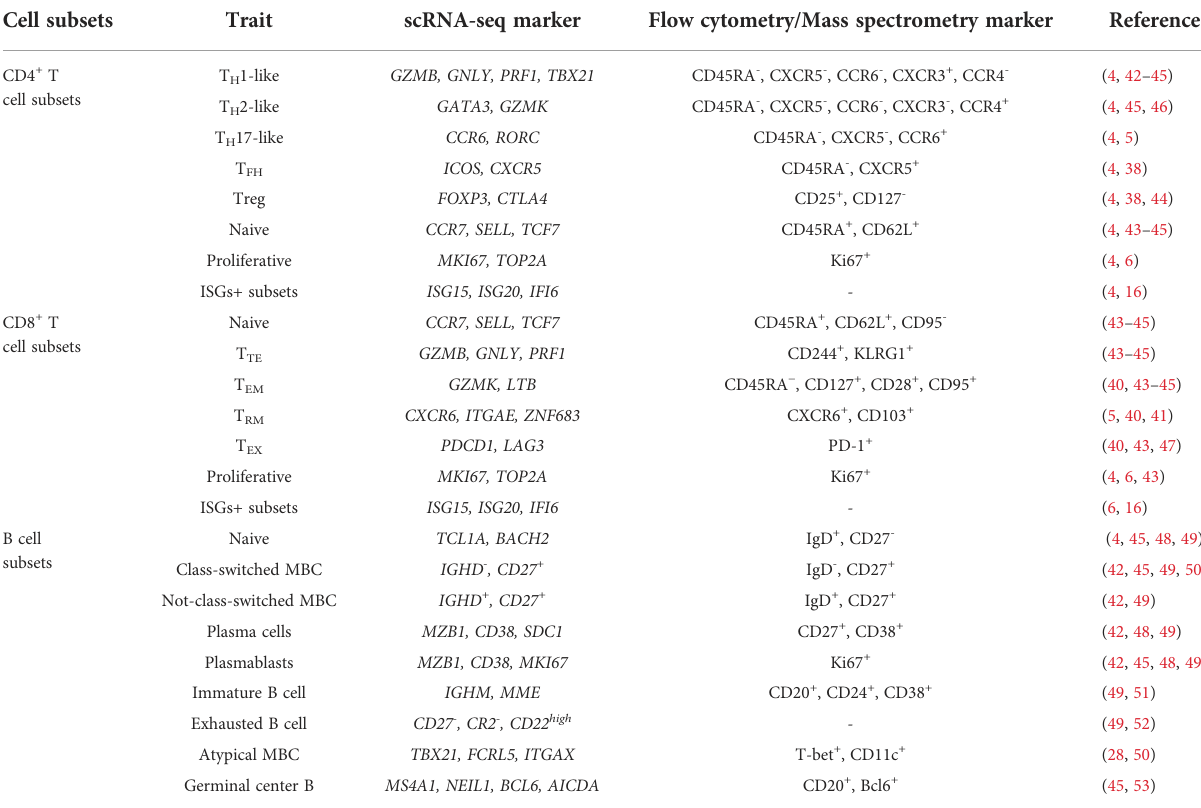
TABLE 2 The T cell and B cell subsets identi fi ed by single cell technologies and their canonical markers. Cell subsets Trait scRNA-seq